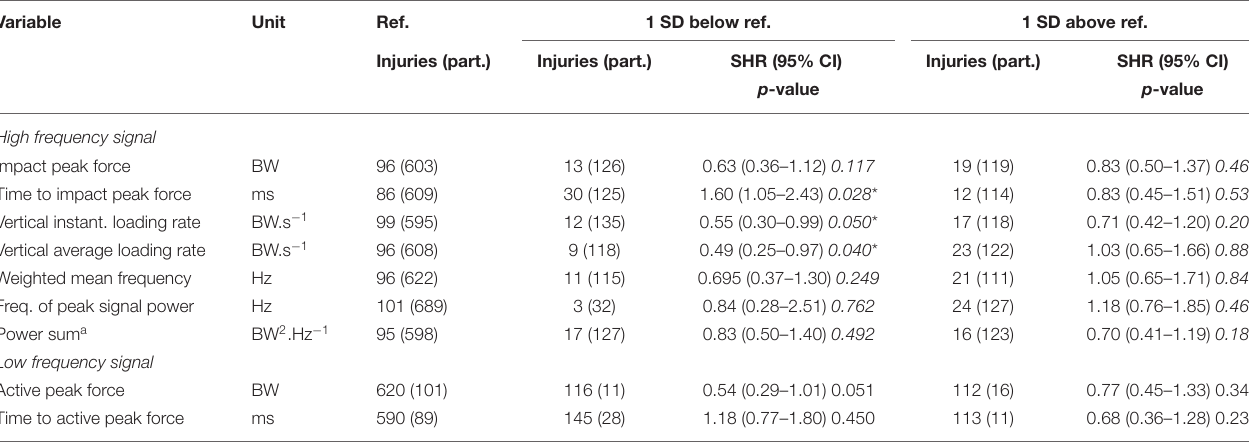
TABLE 4 | Adjusted competing risk regression models for the association between force characteristics of the high and low frequency signals and running-related injury risk ( n = 848).